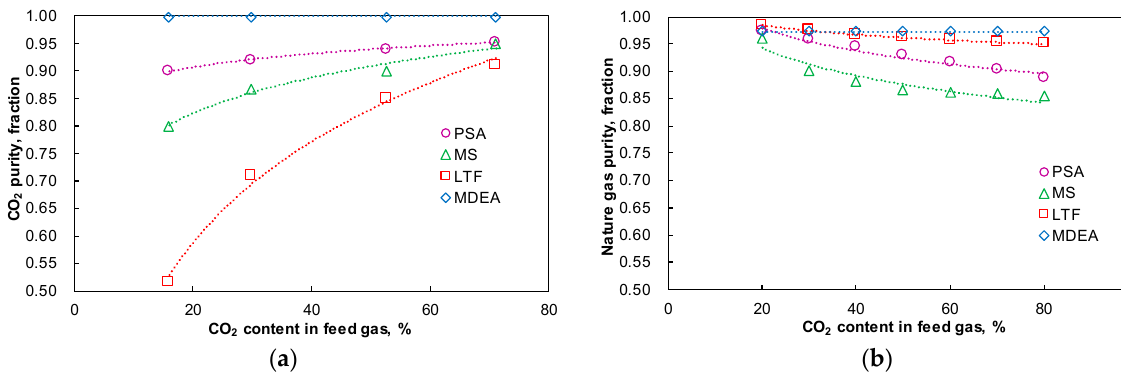
Figure 5. ( a ) CO 2 capture purity, ( b ) hydrocarbon gas capture purityGas capture purity at different CO 2 contents in the feed gas. Table 3. Regression formulas of gas capture purity for different CO 2 capture modules.